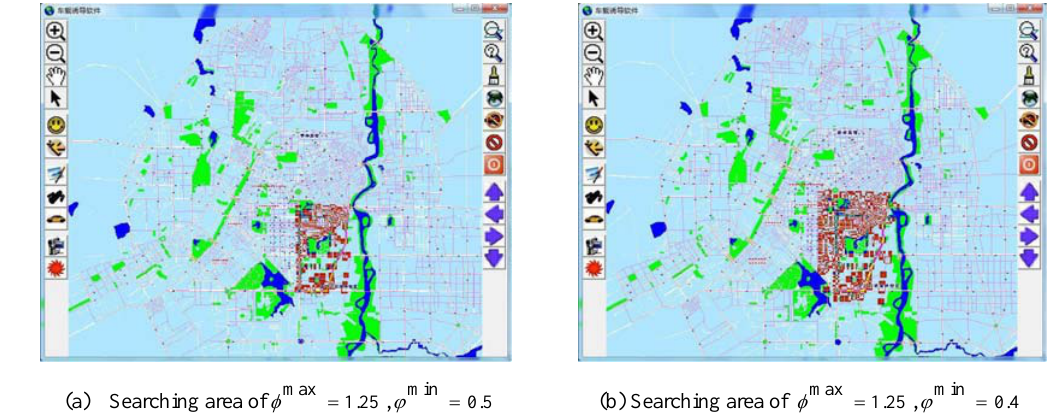
Fig. 5. Dynamic switch of searching area. Table 2. From the comparison of results, operating